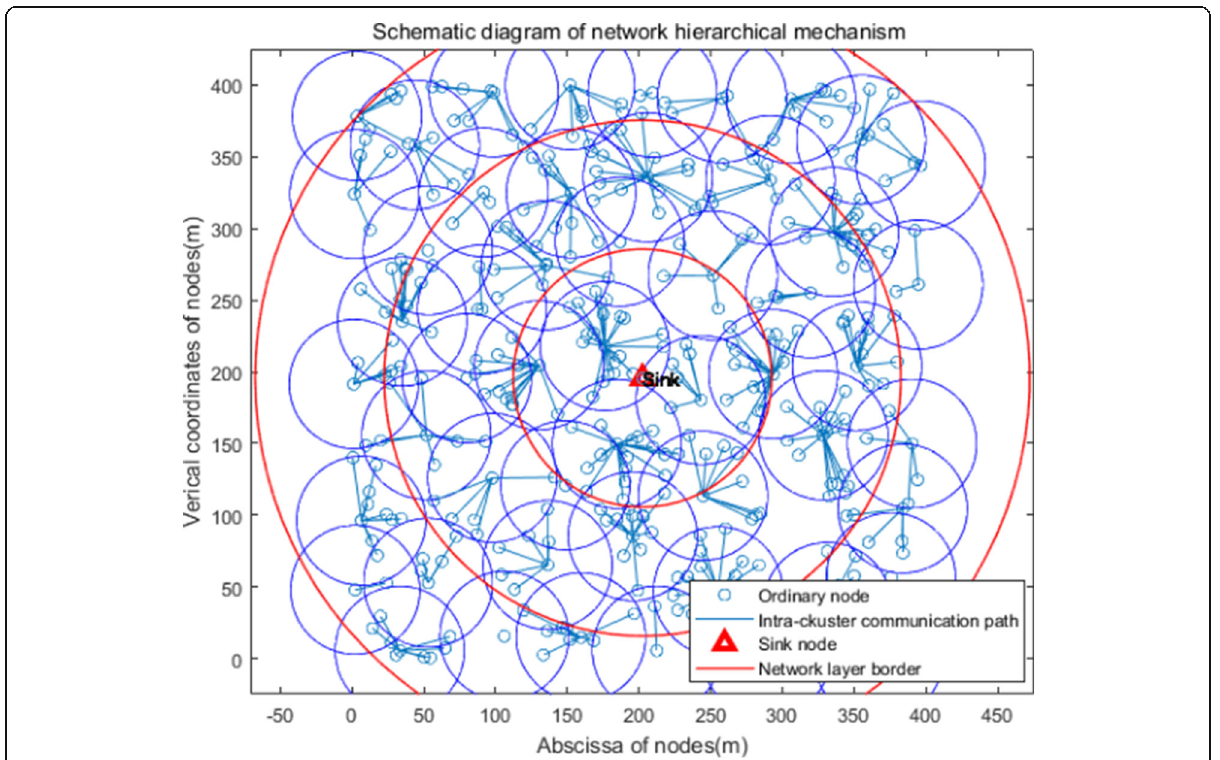
Fig. 4 Hierarchical routing mechanism. A concentric circle with sink node as thecenter is formed to layer each